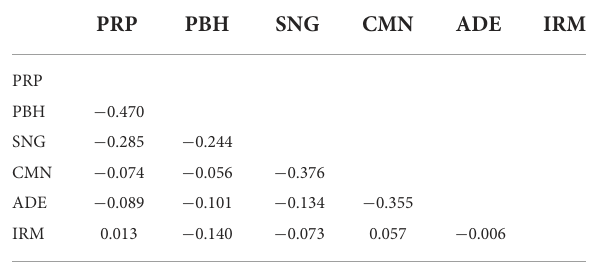
TABLE 2 Convergent validity assessment. TABLE 3 Fornell–Larcker criterion.